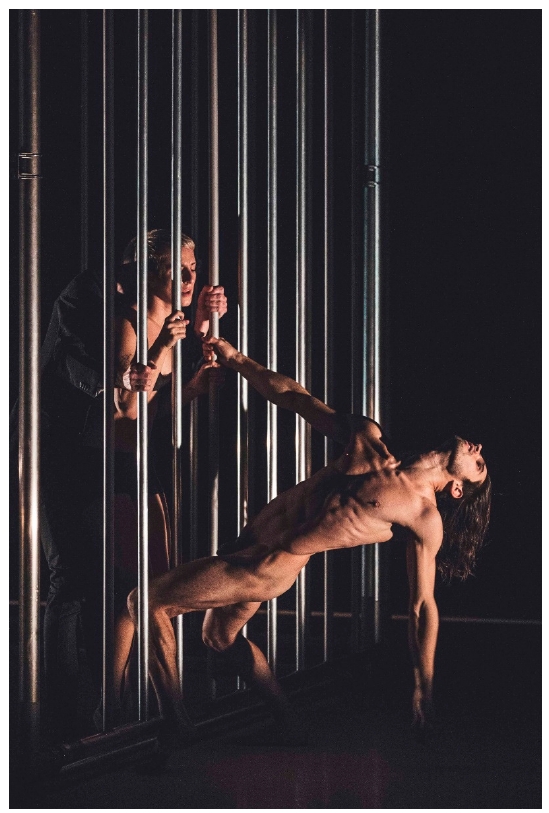
Figure 4. Eoin Mac Donncha, Fanni Esterházy and Anibal dos Santos in Cage —© Orsolya Véner.